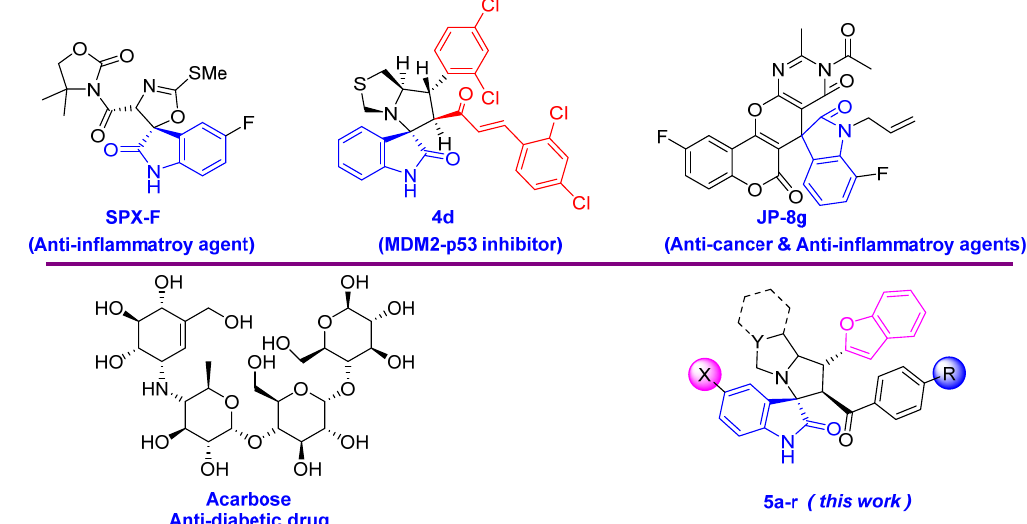
Figure 1. Representative examples of spirooxindoles, benzo[ b ]furan scaffolds, acarbose as standard drug and our designed compounds.